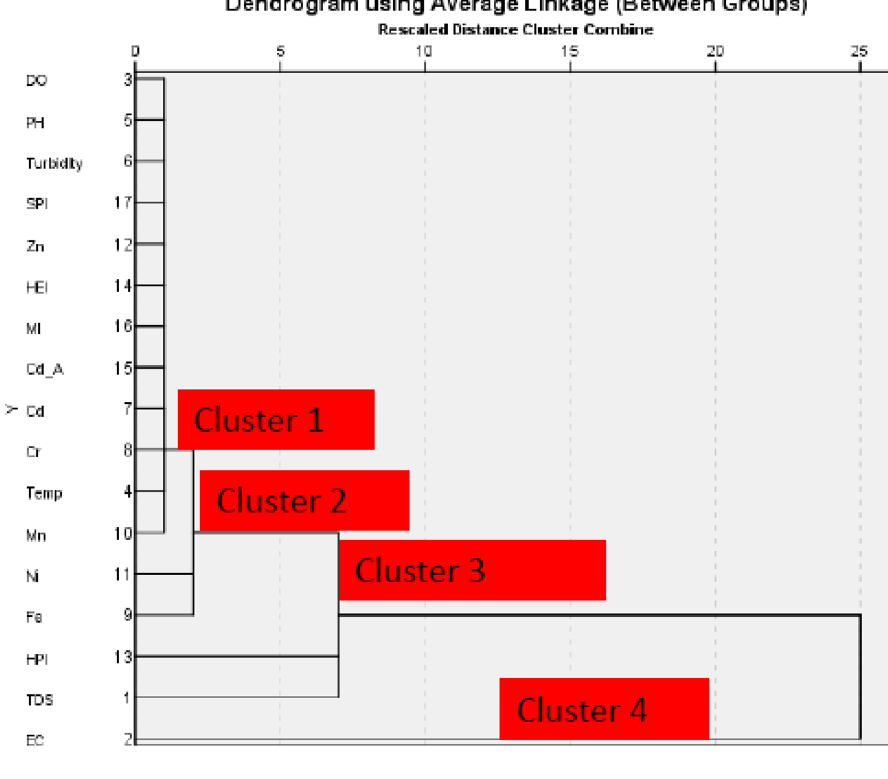
Fig. 5 The dendrogram with the different clusters in the study